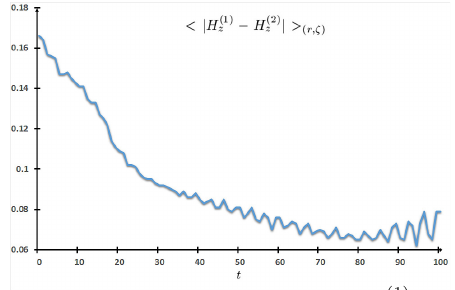
Figure 1. Time dependency of the average < | H (1) z − H (2) z | > ( r,ζ